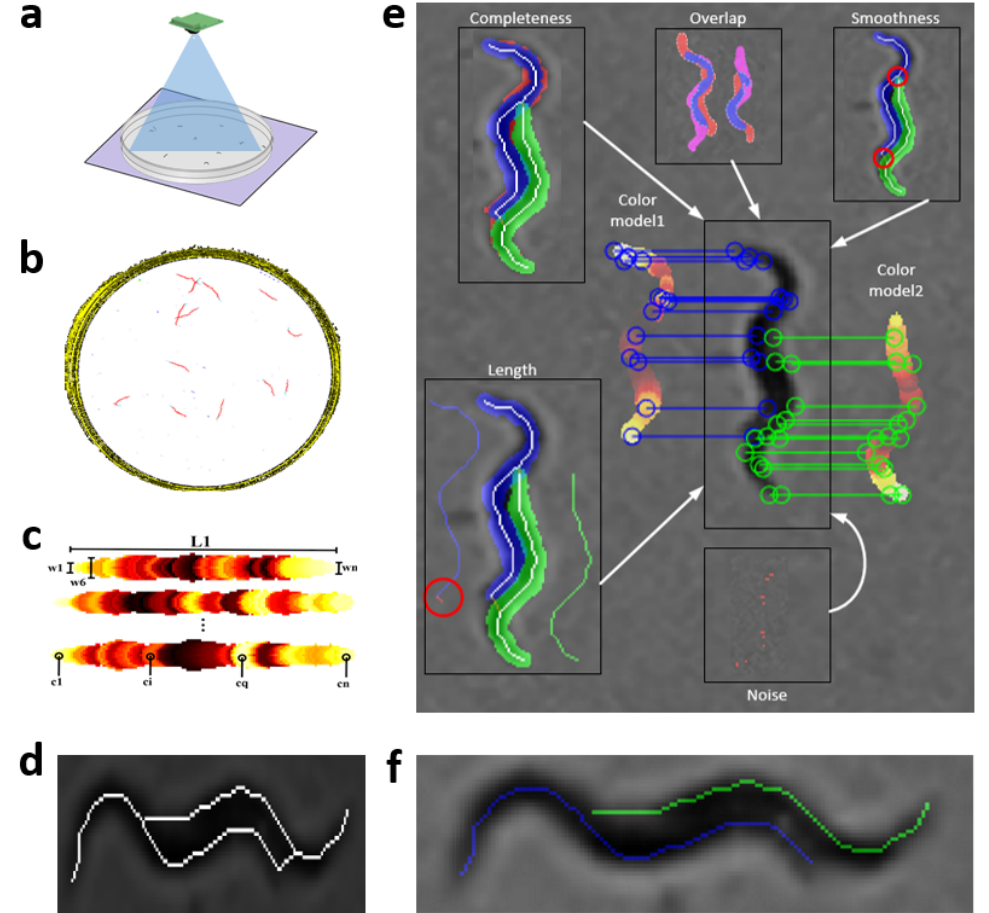
Figure 1. General scheme of image processing. The image shows the different stages that the tracker goes through to obtain the results of the skeletons and to follow all the worms within the plate. ( a ) Image acquisition [37]. ( b ) Pre-processing image. ( c ) Worm models. ( d ) Improved skeleton using proposed method [35]. ( e ) Optimization method. ( f ) Optimization results (predicted